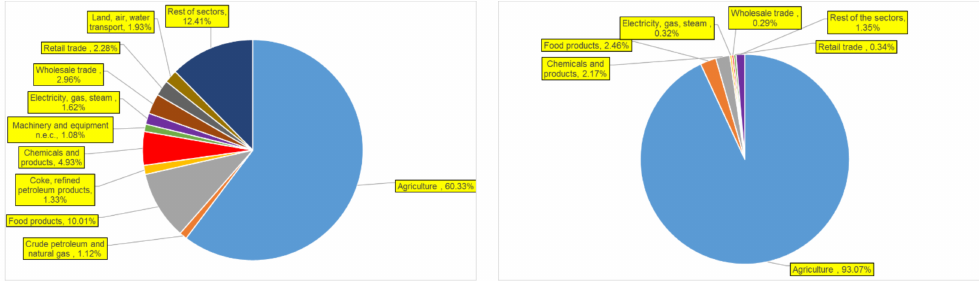
Figure 2. Percentage structure of direct and indirect impacts of the agriculture sector and related sectors in Poland ( left ) and the Lubelskie Region ( right